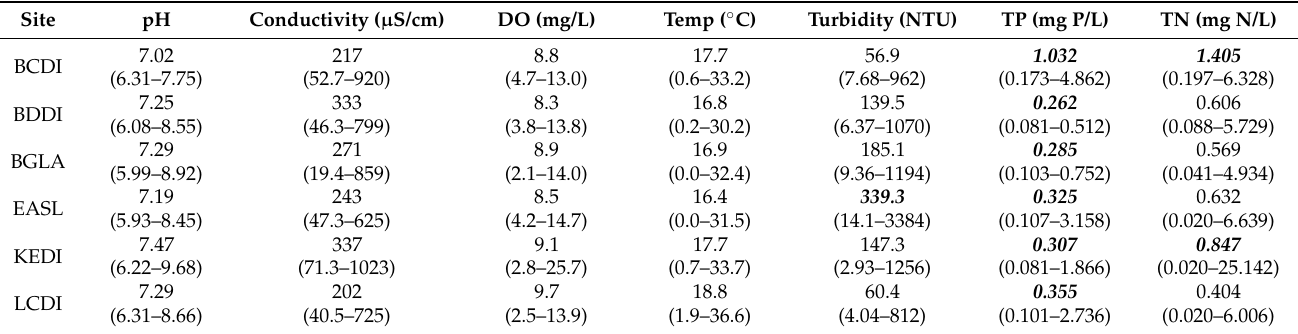
Table 3. Mean values and ranges for physicochemical water quality (pH, conductivity, dissolved oxygen (DO), water temperature), turbidity, and total nutrient parameters (total phosphorus (TP), total nitrogen (TN)) measured from October 2017 to September 2020 at 12 tributaries of the Cache River, Arkansas. Means in bolded italics represent values above state criteria